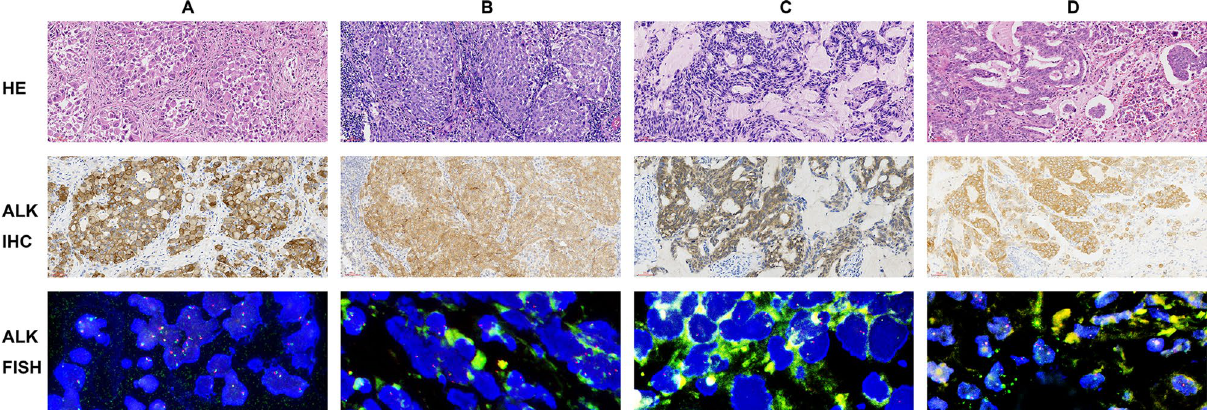
Figure 1. Histopathology of ALK-positive lung cancer and the corresponding ALK protein expression by IHC or ALK rearrangement by FISH. ( A ) Solid adencarcinoma with signet ring cell features. ( B ) Adenosquamous